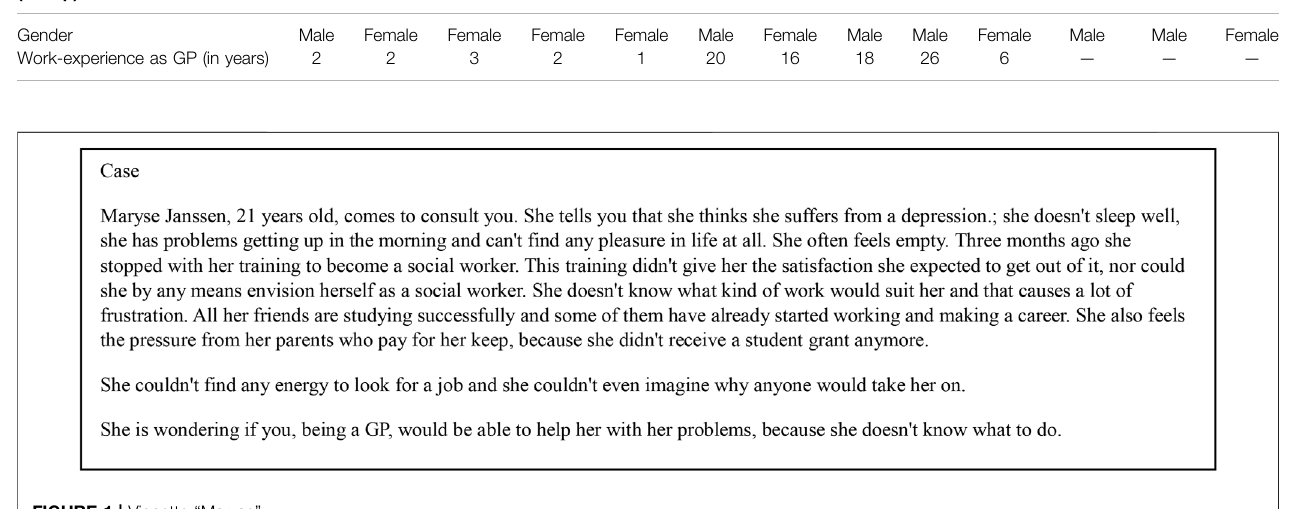
FIGURE 1 | Vignette “ Maryse ”